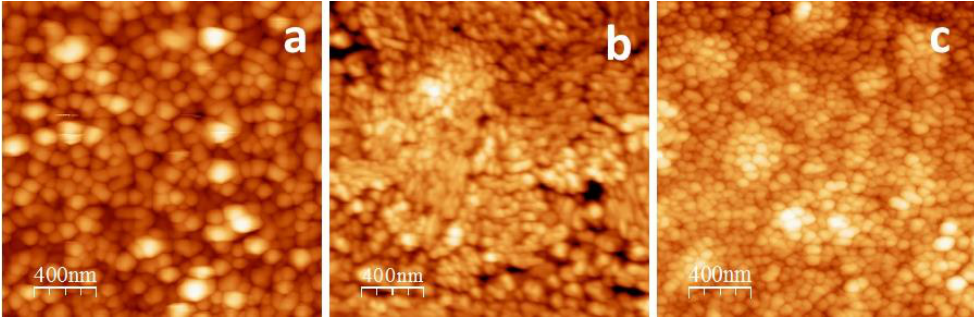
Figure 6. AFM images of ZnPc ( a ); ZnPcF 4 ( b ); and ZnPcF 16 ( c ) films.